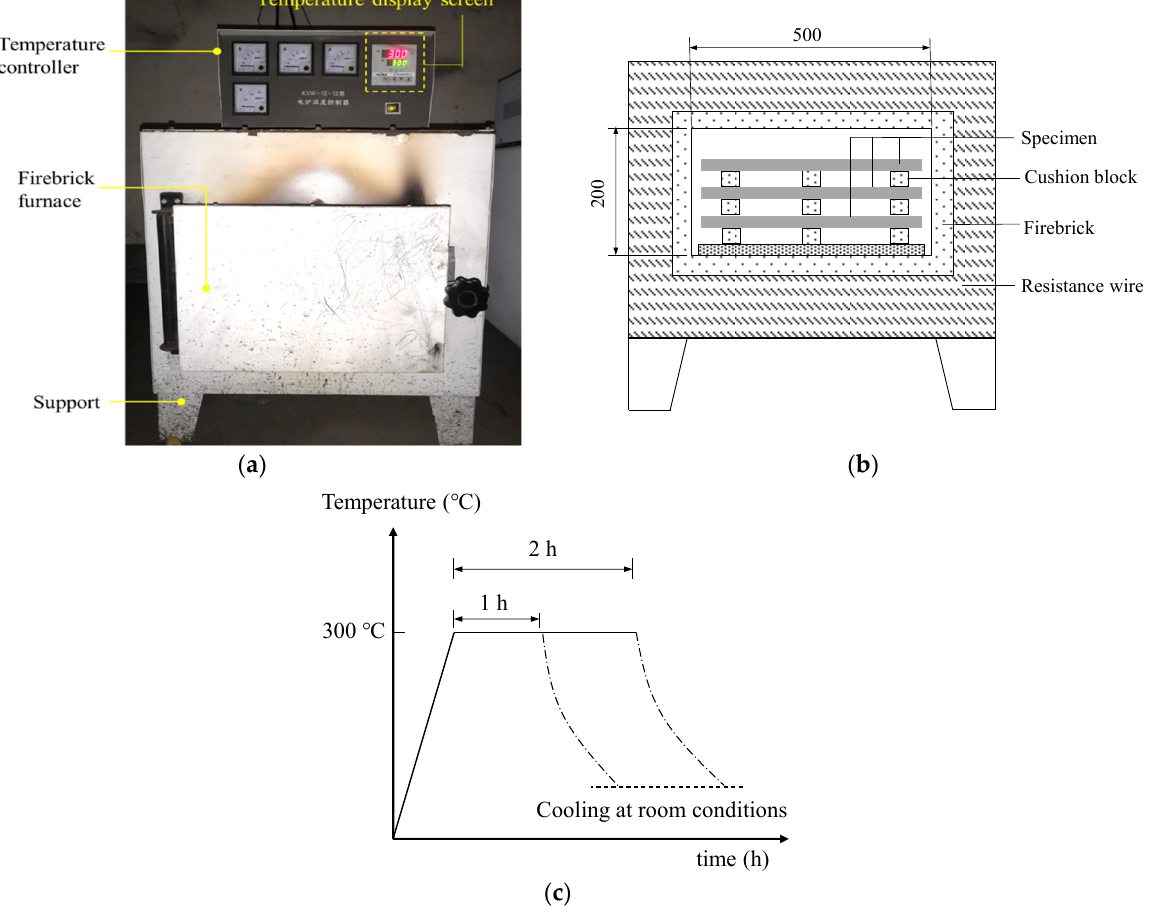
Figure 4. Description of elevated-temperature test procedure (unit: mm): ( a ) high-temperature box resistance furnace; ( b ) schematic diagram of furnace; ( c ) heating regimes.